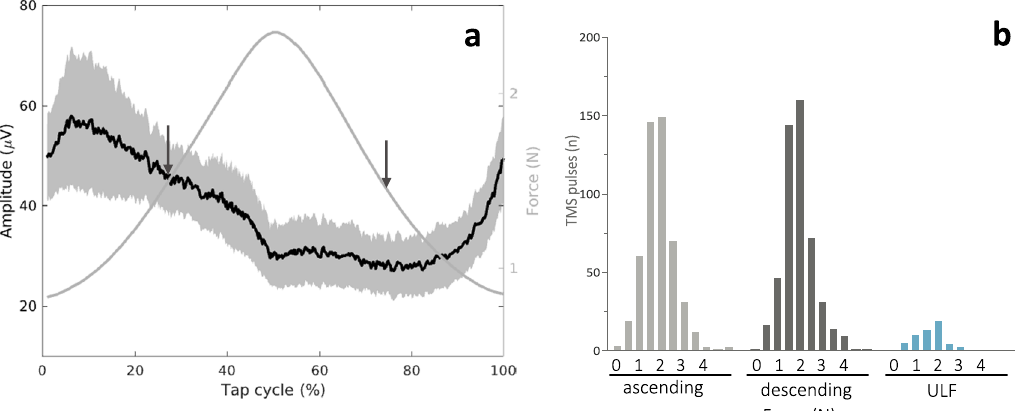
Fig. 2 EMG activity and force relative to the tap cycle. a Average EMG activity over all single taps of all patients (all data). Black line shows mean EMG activity, grey area shows SEM. A real-time signal processing algorithm (based on Simulink Real-Time Version R2016a, MathWorks Inc., USA) triggered single TMS pulses aimed at 25% tap cycle ( = ascending), or 75% tap cycle ( = descending), respectively, with an interstimulus interval of >2.5 s. Arrows show the mean percentage of tap cycle at the actual time of TMS (asc: mean = 27.84, SD = 9.81; desc: mean = 75.19, SD = 8.06). b Histogram of tapping force levels (N) at the time of TMS. There was no signi fi cant statistical difference between force levels at the time of TMS. Please note, that ascending and descending each contain both, data from the transition and regular tapping.